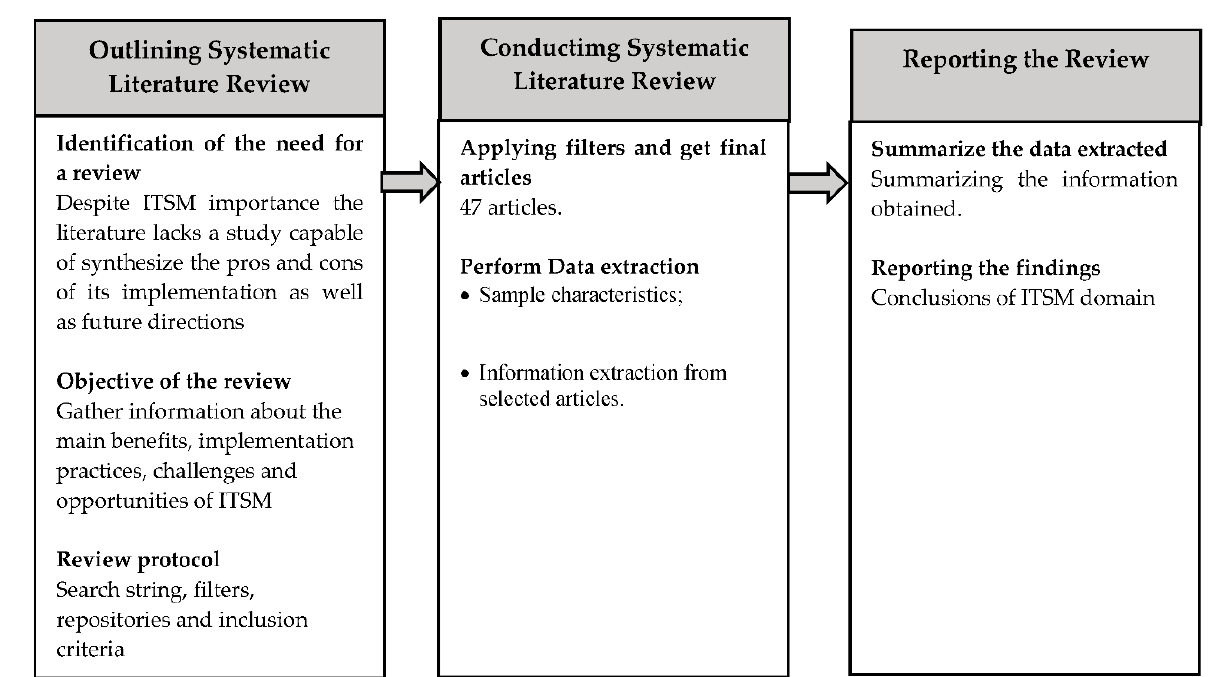
Figure 1. Systematic Literature Review Steps.